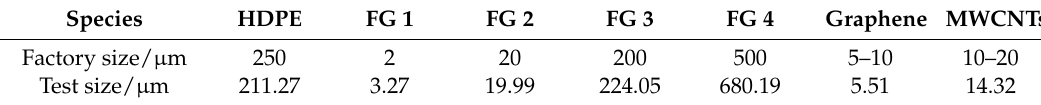
Table 1. Average particle size of high density polyethylene (HDPE) matrix and fillers. Species HDPE FG 1 FG 2 FG 3 FG 4 Factory size/ µ